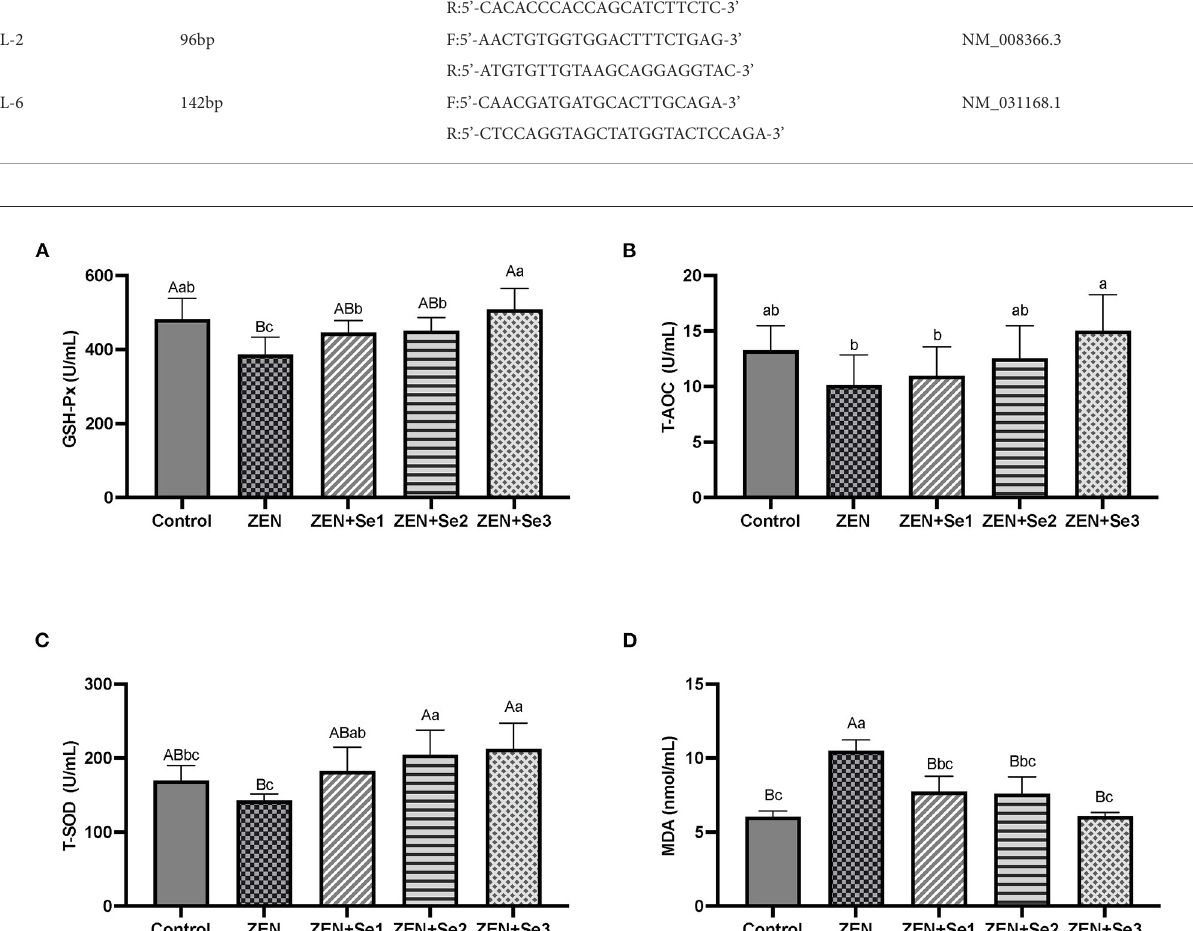
FIGURE1 Effects of SC on plasma levels of different parameters induced by ZEN in mice: (A) GSH-Px activity; (B) T-AOC level; (C) T-SOD activity; (D) MDA content. Different capital letters (lowercase letters) in the column chart indicate a significant difference at the 0.01 (0.05) level.